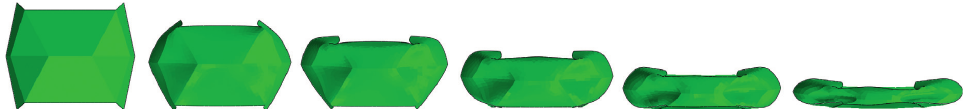
Figure 17: Deformation process of the device under the friction coefficient of